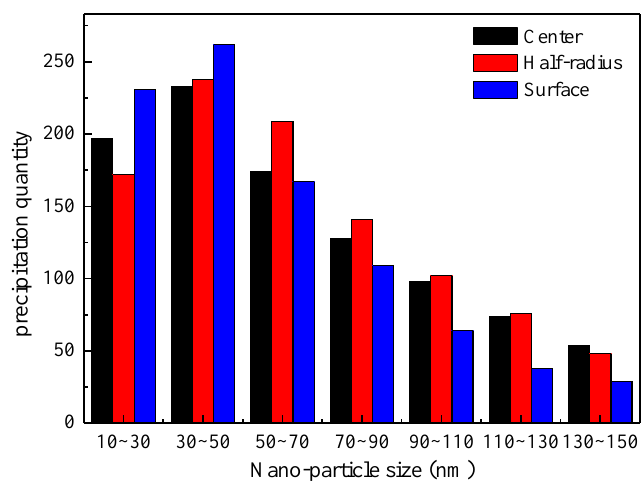
Figure 8. Size distribution of carbides in H13 at the three different locations after tempering.